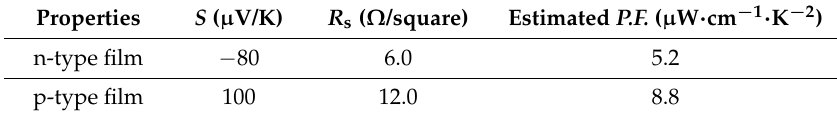
Table 1. Thermoelectric properties of the n- and p-type thin films fabricated by